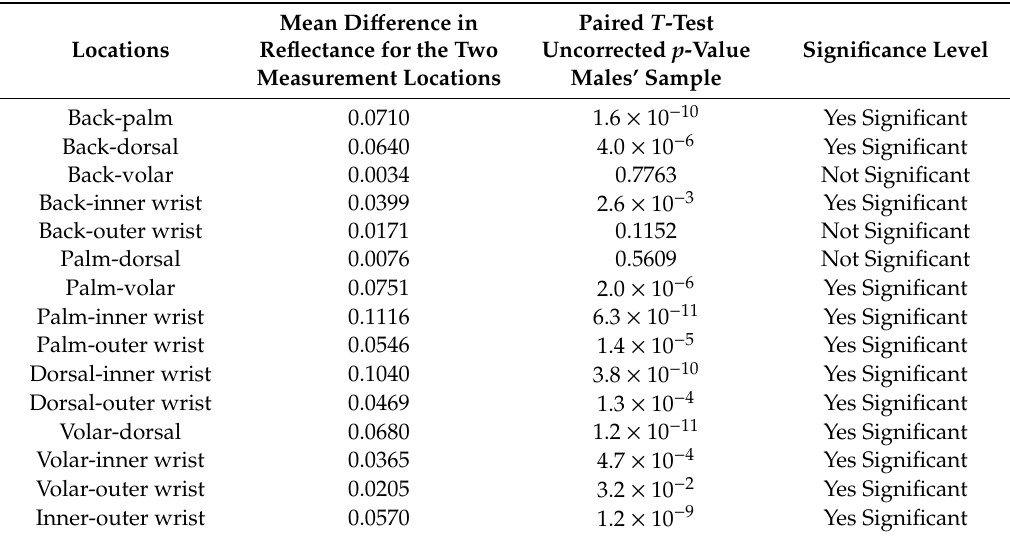
Table 5. Significance level of the mean di ff erences in the reflectance values between all measurements locations of males’